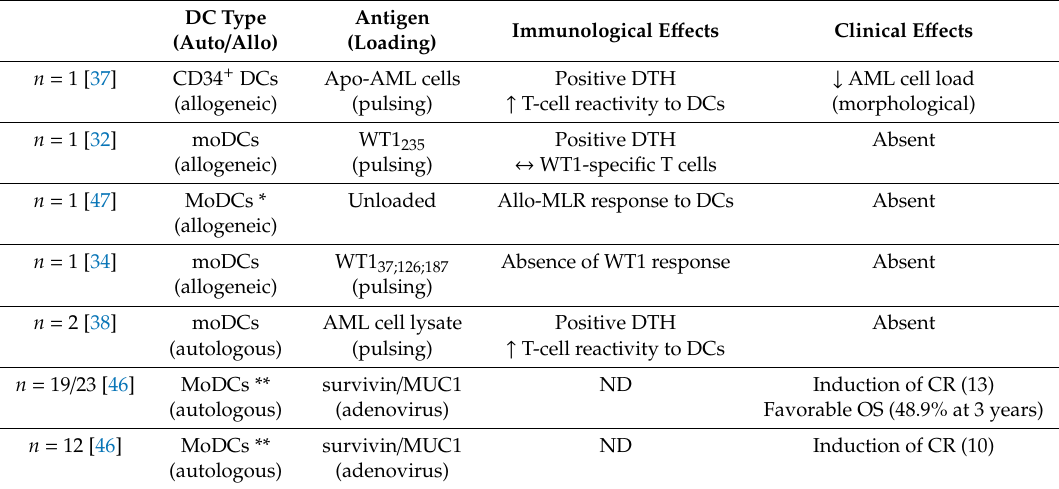
Table 1. Overview of DC (dendric cell) vaccine studies for AML (acute myeloid leukemia) in the post-HSCT setting.